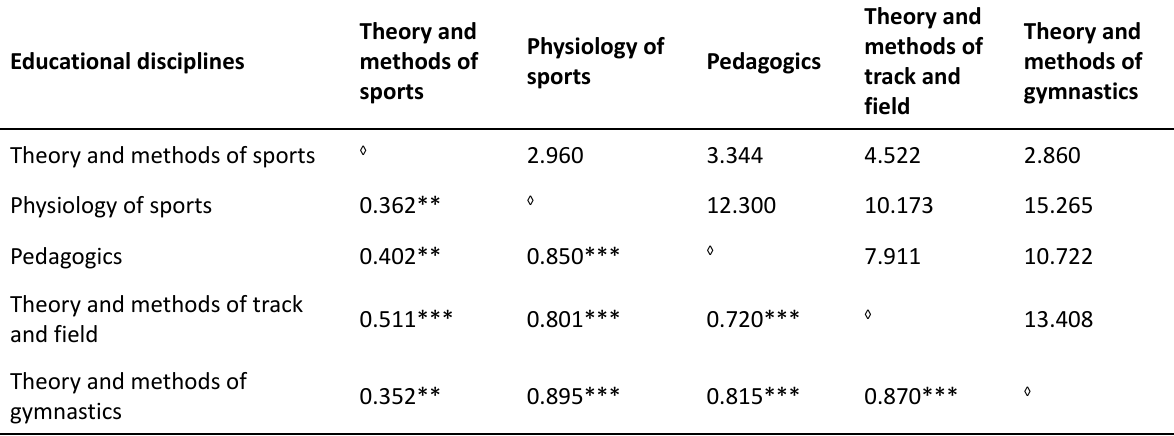
Table 4. Correlation table of the educational disciplines scores on the semester control of 2 nd year: r-Pearson \ t-Student